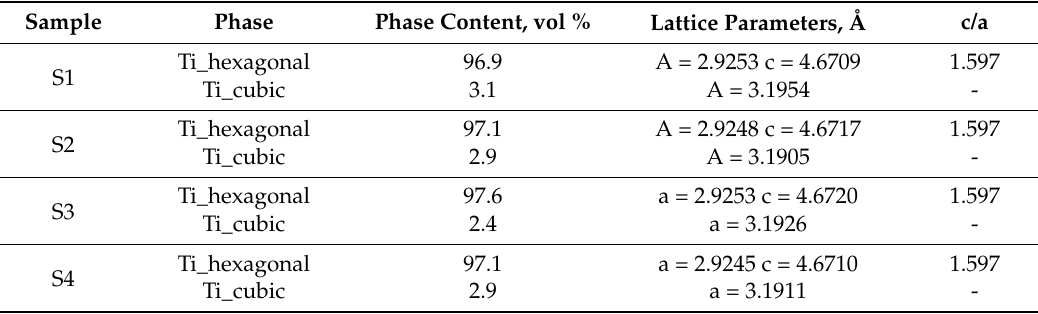
Figure 3. SEM images of the samples ( a , b ) and histogram ( c , d ) of the thickness distribution of α plates, respectively: ( a , c )—S3, ( b , d )—S4. Table 2. Phase composition and lattice parameters in the electron beam melting (EBM)